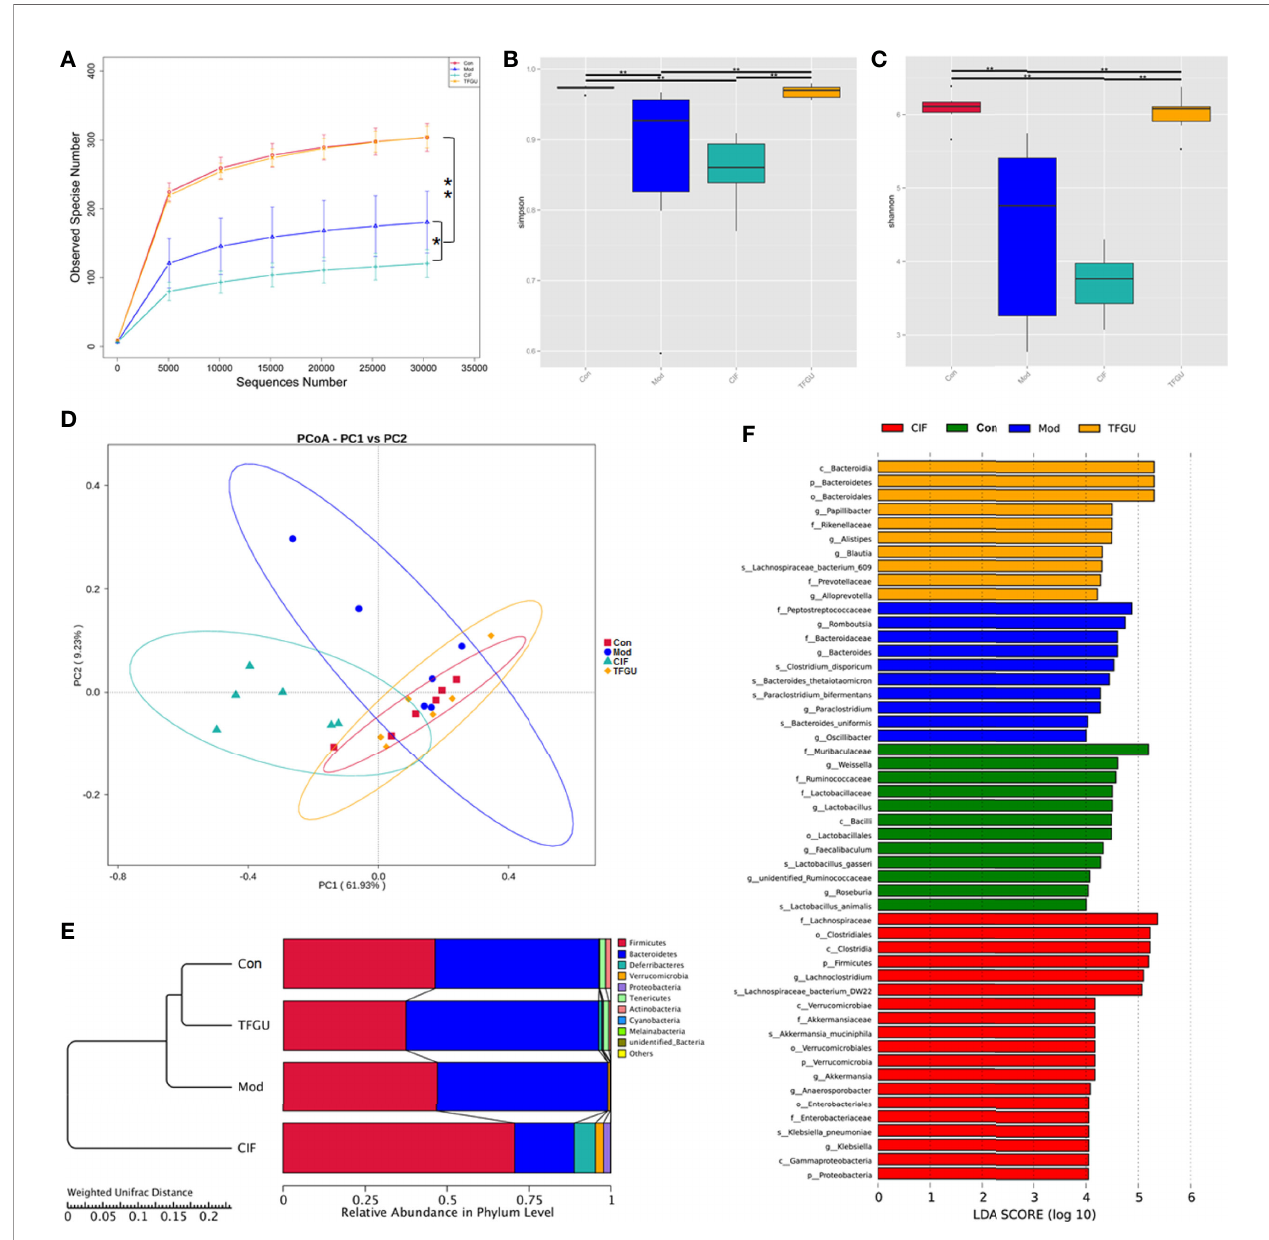
FIGURE 4 | Effects of TFGU on the fecal gut microbiota alterations in CPT-11 – induced colitis mice. (A) The observed species, (B) Shannon index, (C) Simpson index, (D) weighted UniFrac principal coordinate analysis (PCoA) of the microbial composition for all groups. (E) The composition of the intestinal microbiota of all samples at the levels of phylum on CPT-11 – induced experimental colitis in fecal samples of mice (n = 6 mice/group). (F) Linear discriminative analysis (LDA) score represents log changes in relative bacterial taxa representation. The higher the score is, the more important the role is. * P < 0.05, ** P <